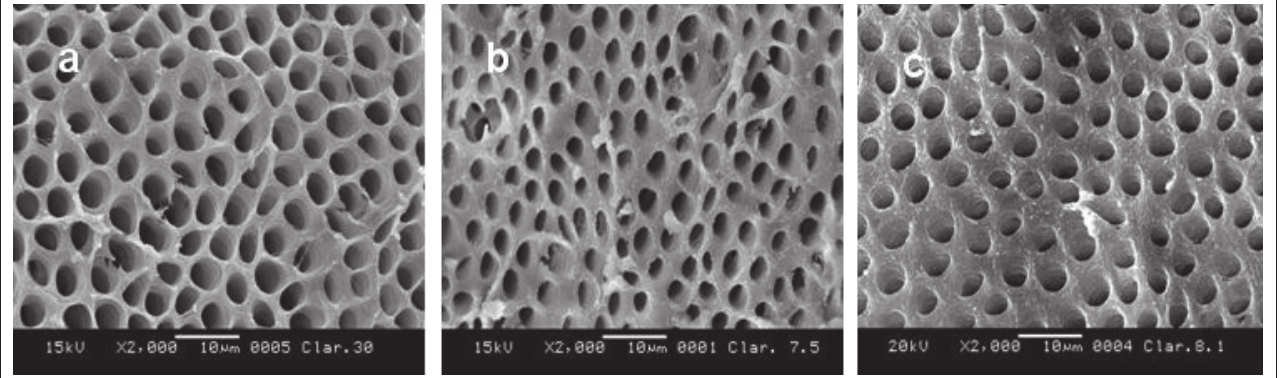
Figure 4 . Scanning electron microscope micrographs of severe altered dentin surface. A: specimens treated with hydrogen peroxide (Group 4). B: specimens treated with carbamide peroxide (Group 5). C: specimens treated with the gel base without carbamide peroxide (Group